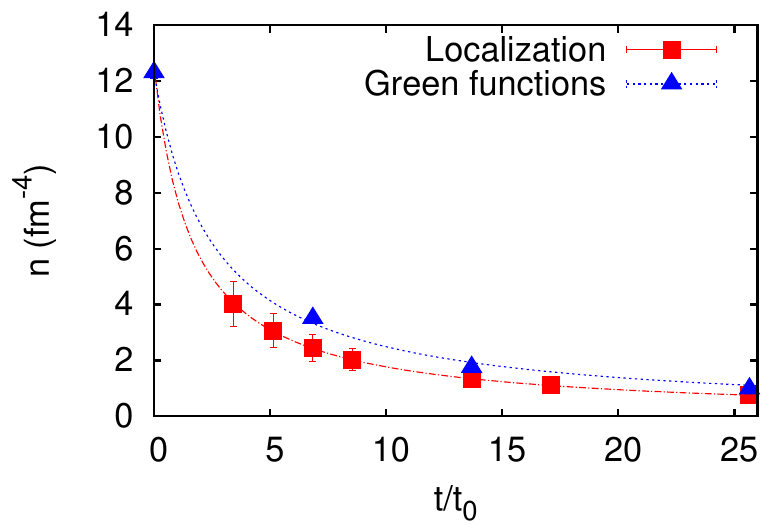
Figure 5 . (Color online) Comparison of the instanton density evolution with Gradient (cid:13)ow time (in units of t 0 = 0 : 01125 fm 2 ) from instanton localization (red) and from (cid:11) MOM ( k ) (blue). The dashed lines correspond to eq. (4.3) resulting from the toy model described in the text which (cid:12)ts either localization (red) or Green’s functions estimates (blue). The value at zero (cid:13)ow time extrapolated from the instanton localization estimates strikingly coincides with the result from the Green’s